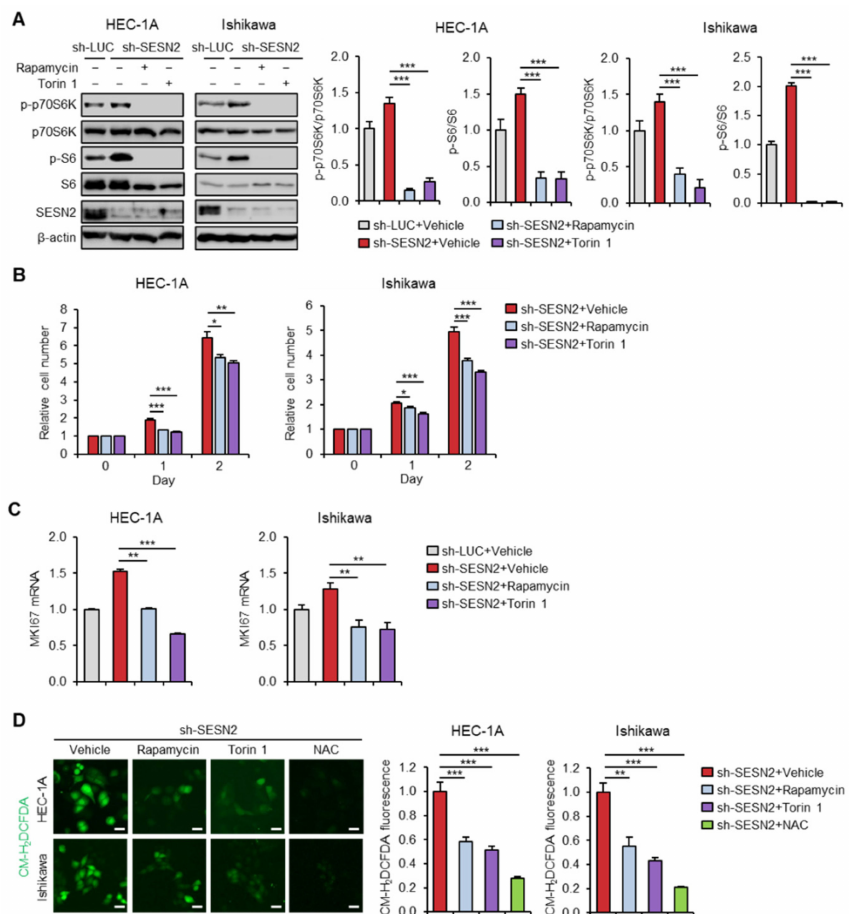
Figure 5. Knockdown of SESN2 increases endometrial cancer cell proliferation and ROS production in a mTOR-dependent manner. ( A ) Immunoblotting analysis for mTORC1-related proteins in HEC-1A and Ishikawa cells infected with lentiviruses expressing shRNAs targeting luciferase (sh- LUC ) or SESN2 (sh- SESN2 ) and treated with 100 nM rapamycin or 250 nM Torin 1 for 24 h. Cell lysates were immunoblotted with anti-p-p70S6K, anti-p70S6K, anti-p-S6, anti-S6, and anti-SESN2 antibodies. β -actin served as a loading control. Band intensities were quantified and normalized with p70S6K or S6 values. ( B ) Cell proliferation analysis in HEC-1A and Ishikawa cells infected with sh- LUC or sh- SESN2 lentivirus and treated with 100 nM rapamycin or 250 nM Torin 1. ( C ) qRT-PCR analysis of MKI67 mRNA levels in HEC-1A and Ishikawa cells infected with sh- LUC or sh- SESN2 lentivirus and treated with 100 nM rapamycin or 250 nM Torin 1 for 6 h. ( D ) Intracellular ROS levels were analyzed by CM-H 2 DCFDA in HEC-1A and Ishikawa cells infected with sh- LUC or sh- SESN2 lentivirus and treated with 100 nM rapamycin, 250 nM Torin 1, or 5 mM N-acetyl cysteine (NAC) for 6 h. Data are shown as mean ± SEM. Results are representative of at least three independent experiments. * p < 0.05; ** p < 0.01; *** p < 0.001 (Student’s t